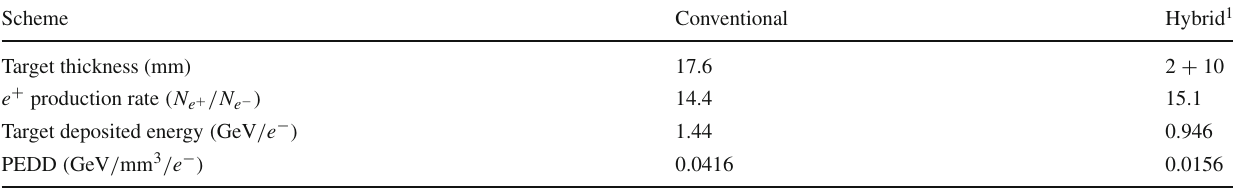
Table 2 Results for the positron production simulations Scheme